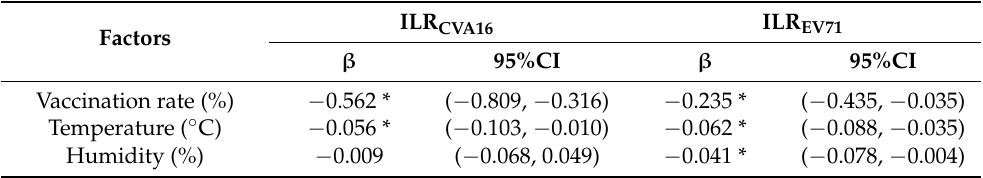
Table 2. Univariate linear regression of HFMD genotype frequency on vaccination rate and climate factors.